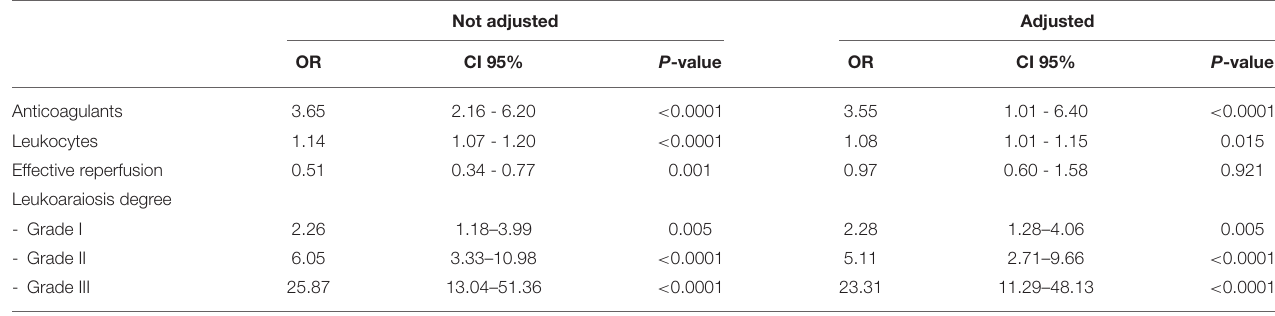
TABLE 3 | Logistic regression analysis including anticoagulants, leukocytes, effective reperfusion, and leukoaraiosis degree.